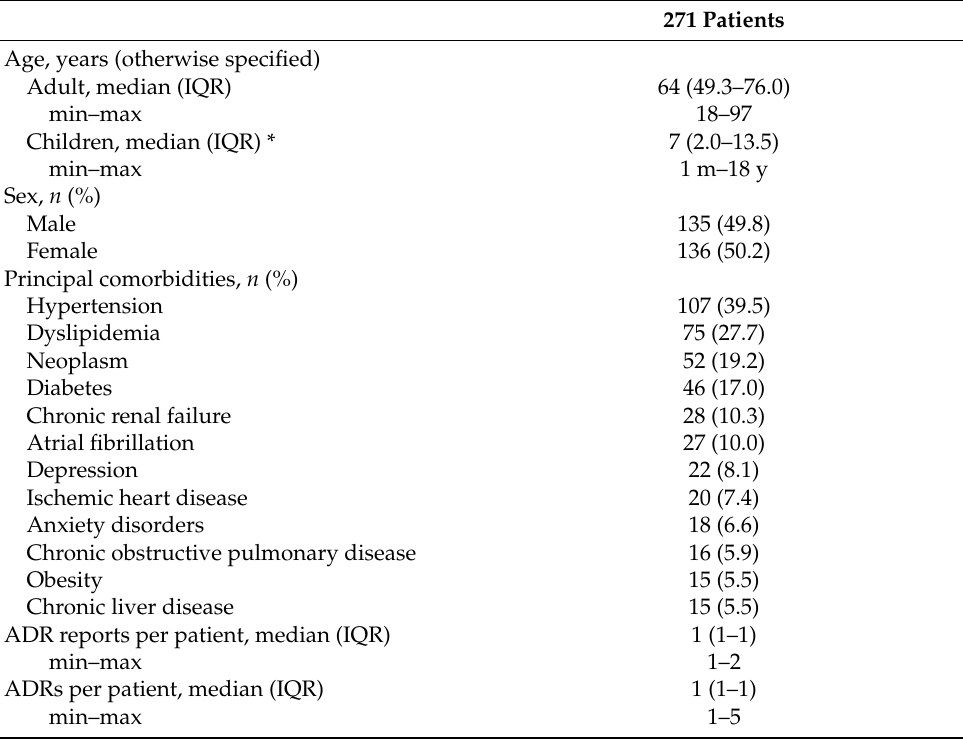
Table 1. Patient baseline characteristics.